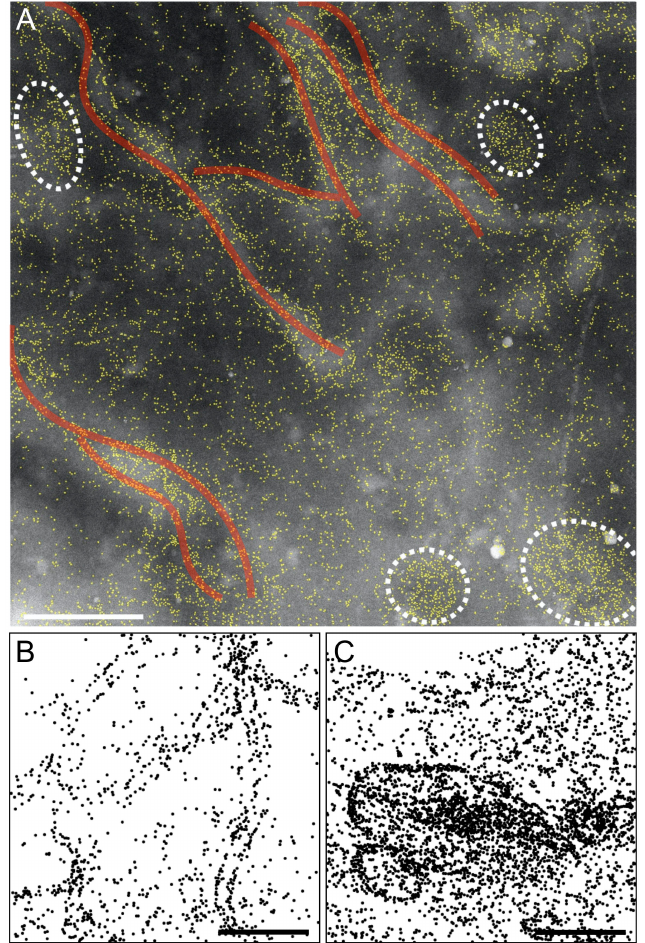
Figure 5. ORAI1 distributions in activated cells display a variety of two-dimensional structures. ( A ) The original STEM image (with QD labels outlined in yellow) gives an impression of the regional cellular morphology, with thicker cellular areas appearing brighter than thinner ones. A bulging membrane topography often matches with dense accumulations of ORAI1. Typical ellipsoid puncta (outlined with dashed lines) and nearby running several micrometer-long strands of aligned ORAI1 (transparent red traces) can be seen. ( B , C ) show other processed STEM images from cells with a rela- tively lower ( B ) and higher ( C ) ORAI1 expression level, displaying all detected labeled ORAI1, includ- ing monodisperse and dimeric label conformations, as 35 nm diameter circles. In ( B ), micrometer-long chains of ORAI1 formations emerge, several of them running in parallel. In ( C ), ellipsoid ring-like structures of ORAI1 distributions of different dimensions are visible, with the larger of these struc- tures enclosing a central region of condensed ORAI1. Scale bars = 1 µ